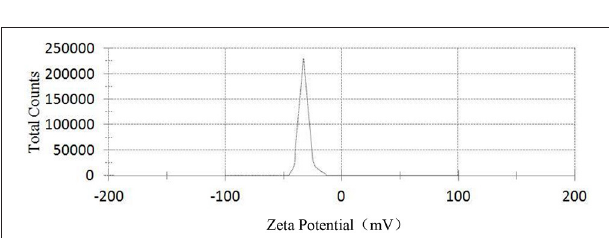
FIGURE 5 | Zeta potential of PLA combined Fe 3 O 4 -GO-ASA